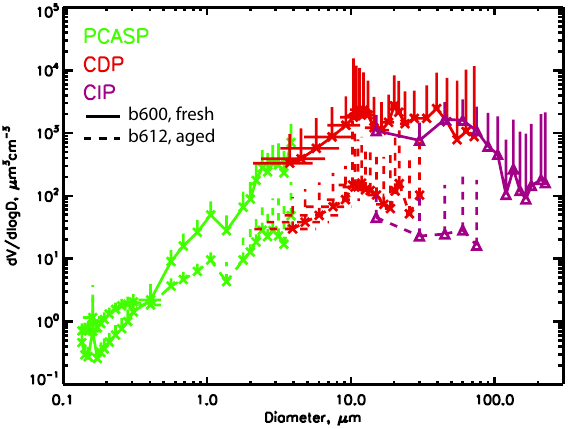
Figure 4. Example size distributions measured in different dust lay- ers during Fennec 2011. Size distributions were measured using the PCASP (green), CDP (red) and CIP15 (purple). Solid lines show measurements from b600 during active uplift close to the desert sur- face; dashed lines show measurements from b612 which was dust aged by several days and well-mixed within a deep SABL. Verti- cal error bars show one standard deviation of the data combined with instrumental uncertainty, and only upwards errors are shown for clarity. Horizontal errors show uncertainty in bin centre diame-